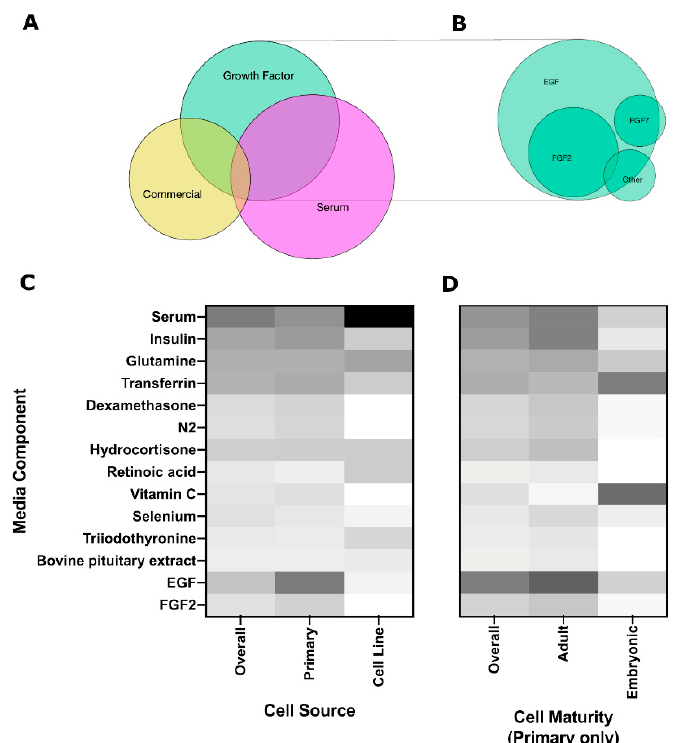
Figure 5. Categorization of the media type and percentage frequency of individual media compo- nents. Venn diagrams comparing the prevalence of different ( A ) media categories and ( B ) growth factors used in the growth factor-based media category. Heat maps comparing the percentage frequency of different media components by ( C ) cell source and ( D ) cell maturity for primary cells.